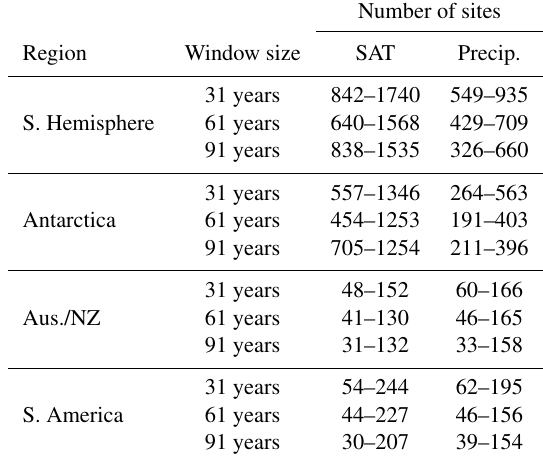
Table 1. The range in the number of sites available for use in a SAT or precipitation proxy network in each region and the calibration window size. The range was calculated across the 10 different cal- ibration windows used when creating the network, as discussed in Sect.